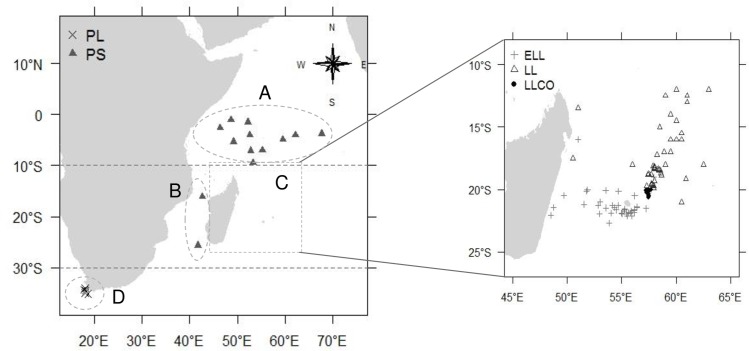
Map of the western Indian Ocean showing positions of sampled albacore tunas by latitudinal area and region, and by gear. Seychelles waters located north of 10°S (region A), Mozambique Channel (region B) and Mauritius and Reunion Island waters (region C) both regions located at latitudes 10–30°S, and South Africa waters located south of 30°S (region D). Black crosses: pole-and-liner (PL), grey triangles: purse-seiner (PS), grey crosses: longliner targeting swordfish (ELL), white triangles: deep-freezing longliner (LL), black dots: coastal longliner (LLCO). Regions are separated by grey dotted lines.